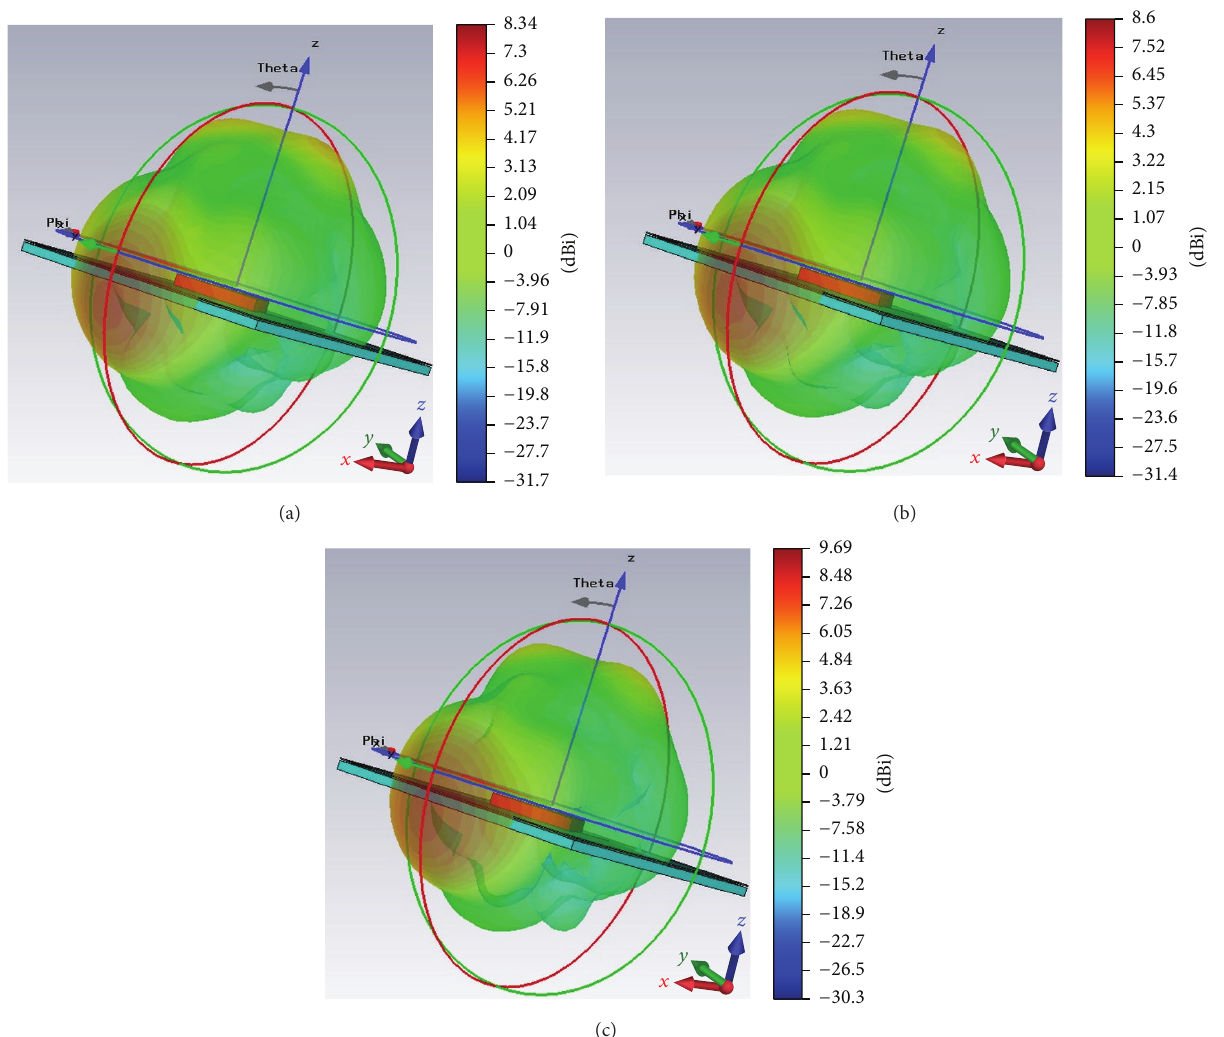
Figure 9: (a) 3D end-fire pattern at 192.5 THz. (b) 3D end-fire pattern at 193.5 THz. (c) 3D end-fire pattern at 197 THz.